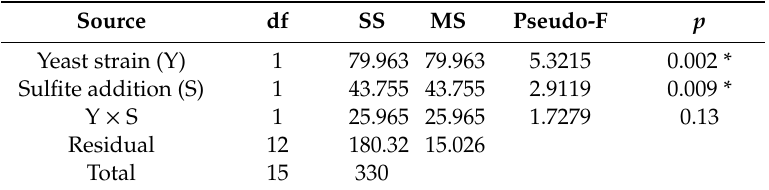
Table 2. Results of a two-factor PERMANOVA evaluating the e ff ects of yeast strain and SO 2 addition on the volatile secondary metabolite profiles of pinot gris wines. Results with an asterisk (*) are significant at α = 0.05.